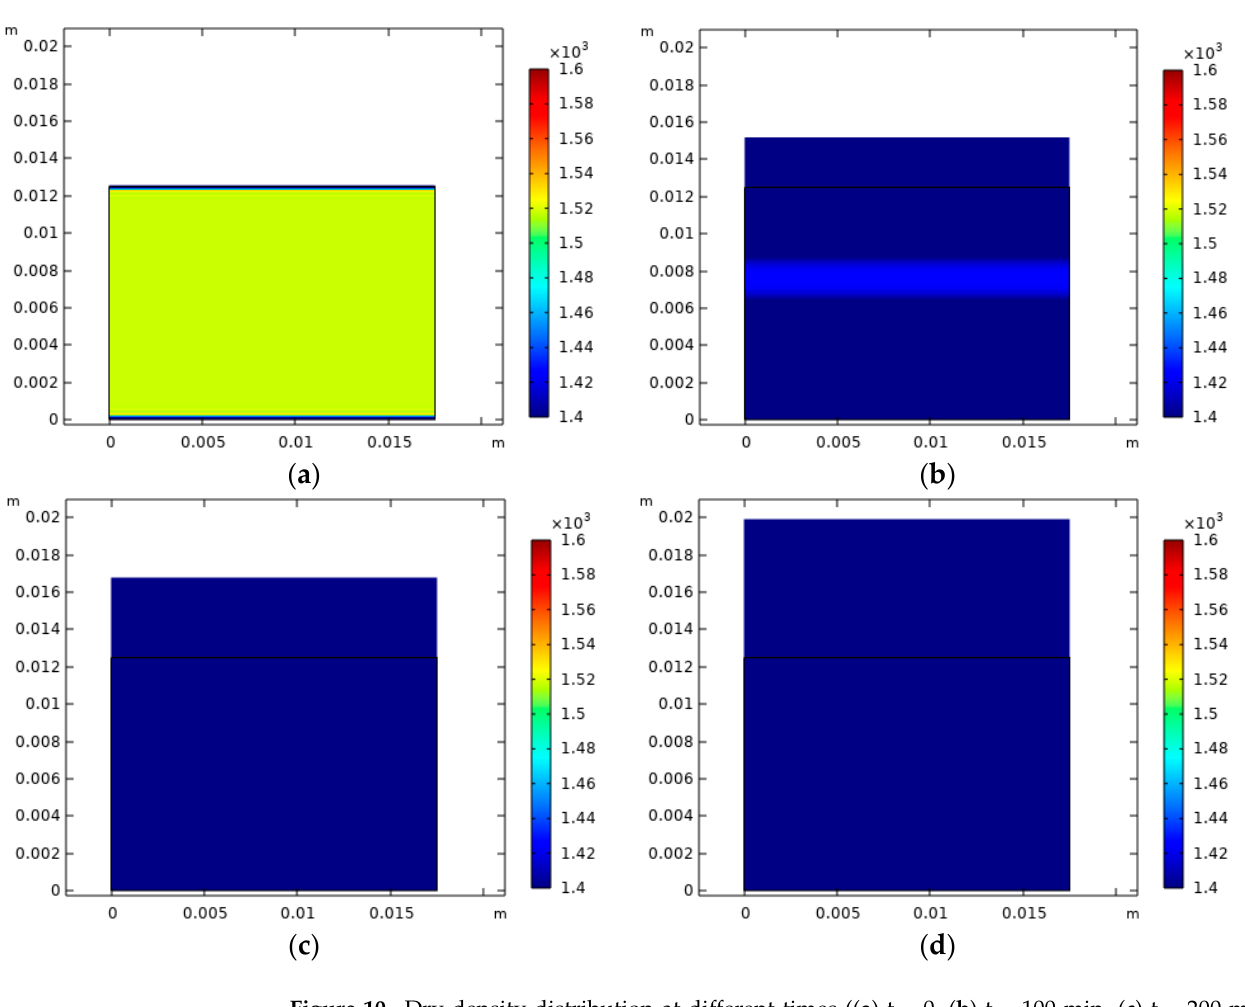
Minerals 2022 , 12 , x FOR PEER REVIEW